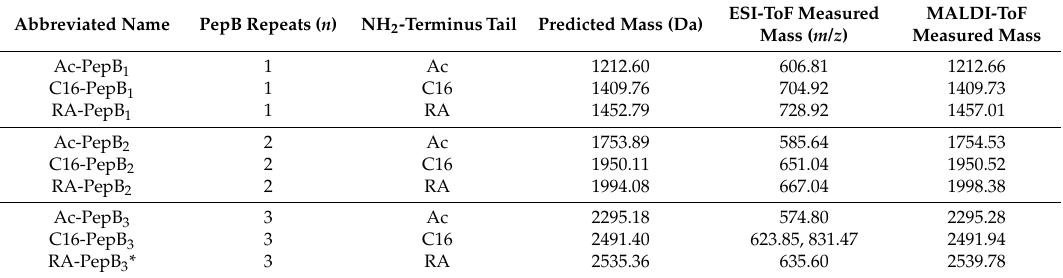
(Table 2). The exact mass was also matched using matrix-assisted laser deposition/ionization time-of-flight mass spectrometry (MALDI-ToF MS) (Table 2). Table 2. Exact mass analysis from mass spectrometry (MS). All PepB variants had matching m / z . * PepB variant ultimately utilized for the differentiation study detailed in Section 3.5. ESI-ToF: electrospray ionization time-of-flight. MALDI-ToF: matrix-assisted laser deposition/ionization time-of-flight.